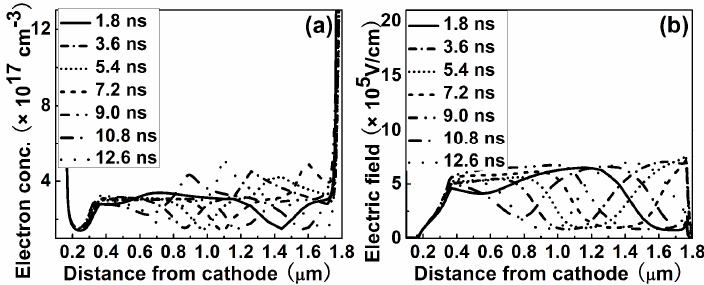
Figure 11. Electron concentration ( a ) and electric field ( b ) profiles derived inside one oscillation circle at the same time step, when L ac = 1.4 μ m and N ac = 3 × 10 17 cm − 3 under EB model.